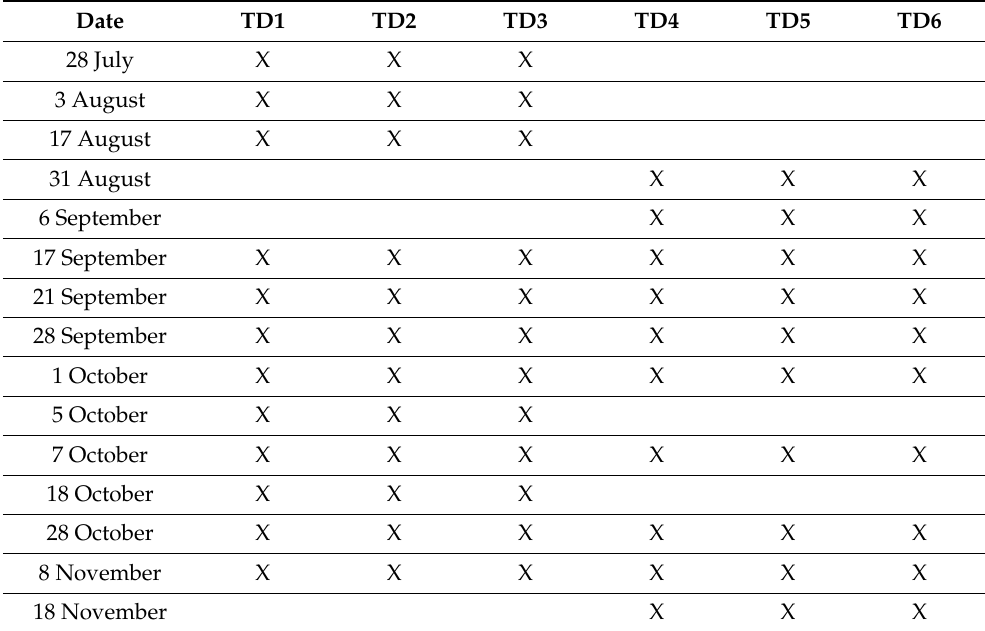
Table 4. Dates between July and November 2021 when TD data were acquired with the